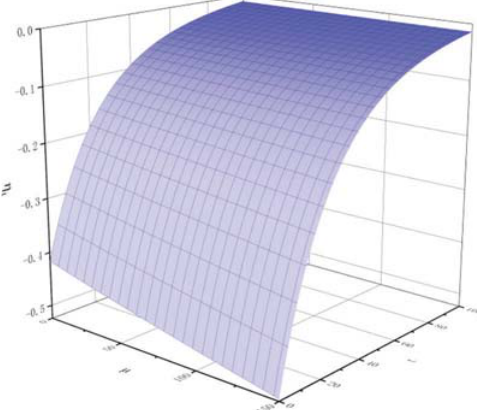
Figure 7: The partial derivative curve of